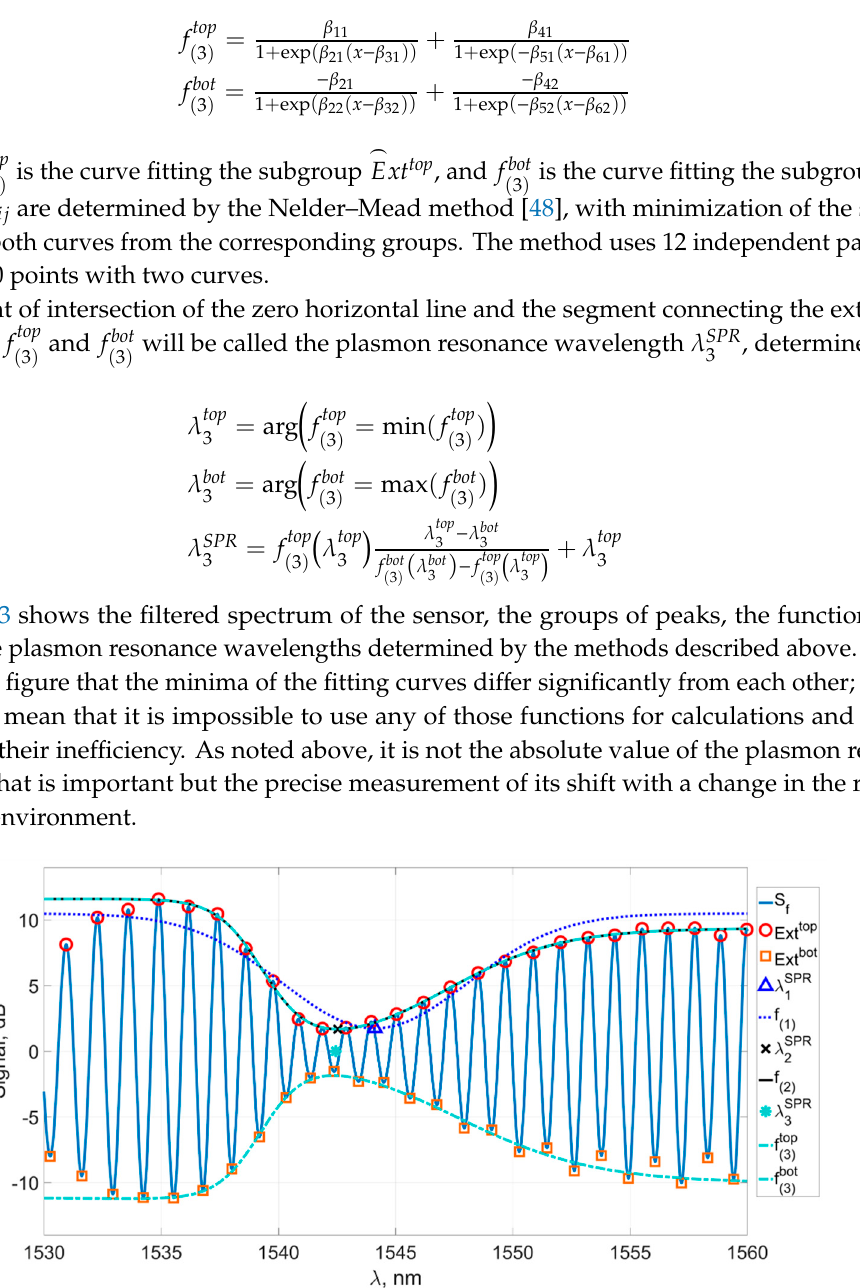
Figure 13. The filtered spectrum of the sensor’s signal, subgroups Ext top (circles) and Ext bot (squares) and their fitting curves, corresponding to different methods.